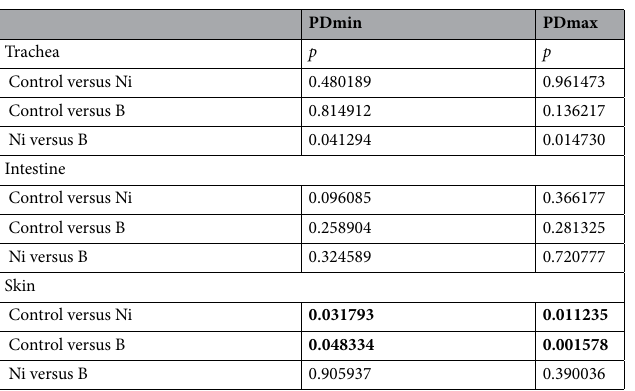
Table 9. Results of the Mann–Whitney test ( p < 0.05) for minimal and maximal transepithelial electric potential (PDmin and PDmax) measured during 15-s stimulations for the tissue specimens. Control—the specimens incubated in the bumetanide (0.1 mM) solution, Ni—the specimens incubated in the nickel chloride (0.1 mM) and bumetanide (0.1 mM) solution, p < 0.05;